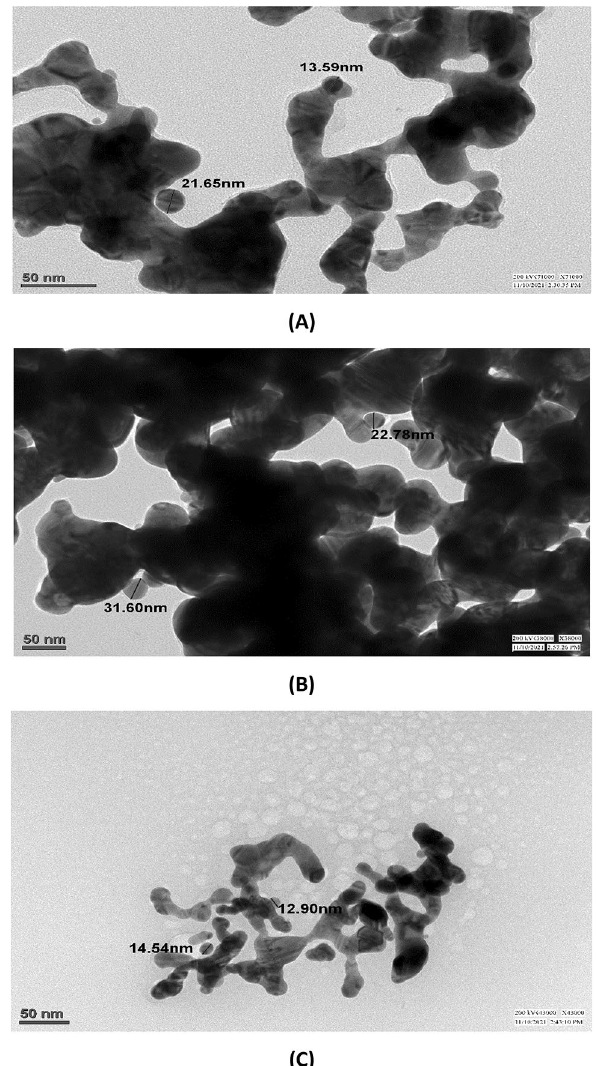
Figure 8. ( A – C ) TEM micrographs of AuNPs synthesized from the essential oil of C. flexuosus from diverse altitudes of ( A ) Palampur (AuS1), ( B ) Haryana (AuS2) and ( C ) Dehradun